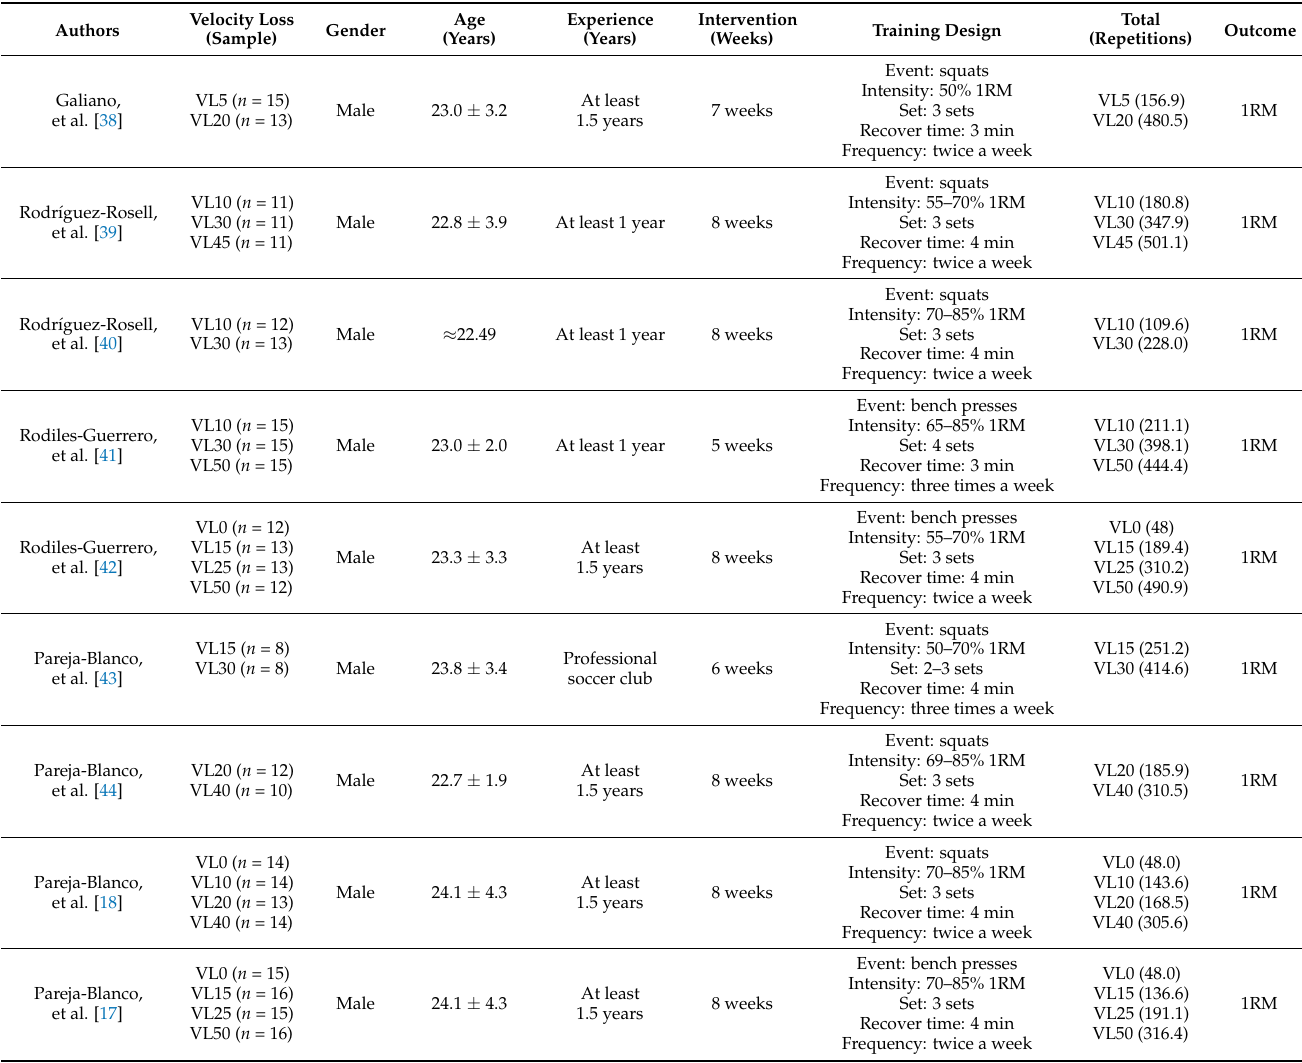
Table 2. The characteristics of the included